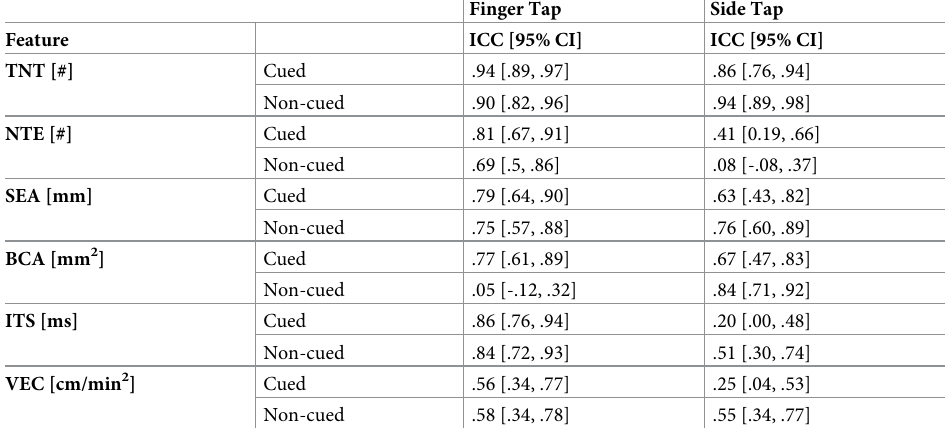
Table 3. Within-day